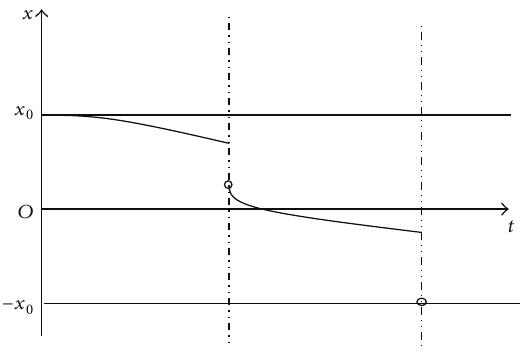
Figure 3: A one-side periodic